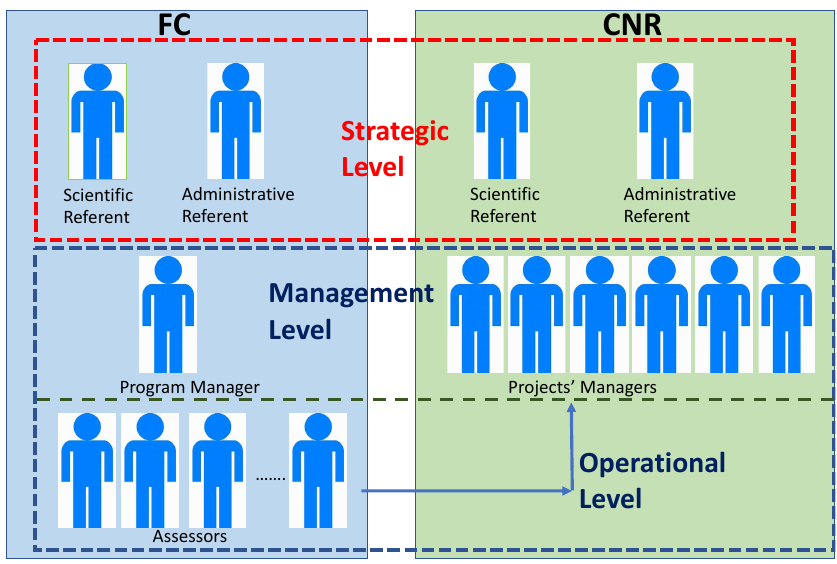
Figure 3. The management structure adopted.